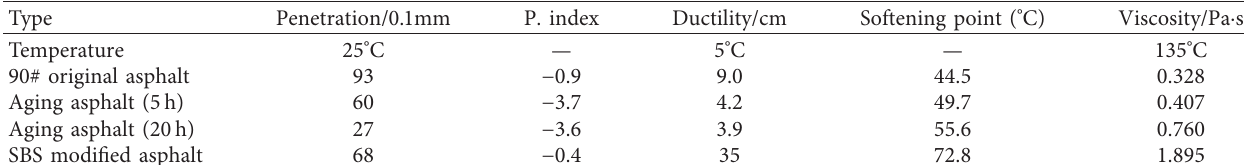
Table 1: Indexes of 90# original asphalt and aging asphalt in different aging time.